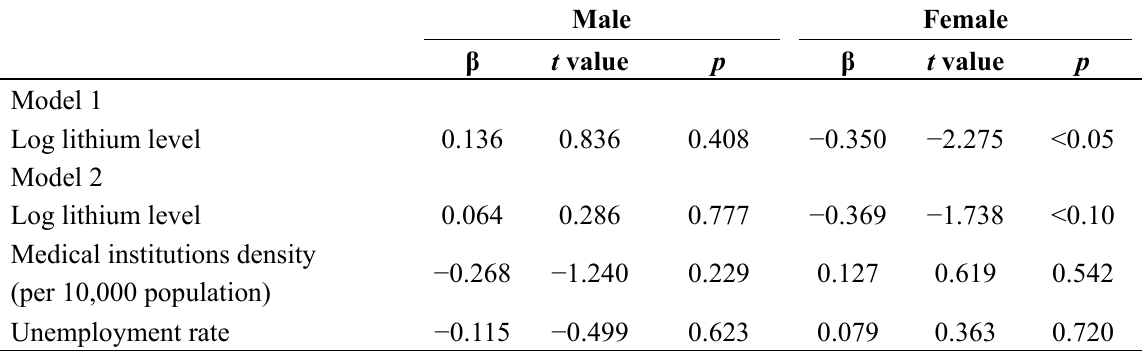
Table 1. Least squares regression model weighted for the size of each population on standardized mortality ratios (SMRs) for